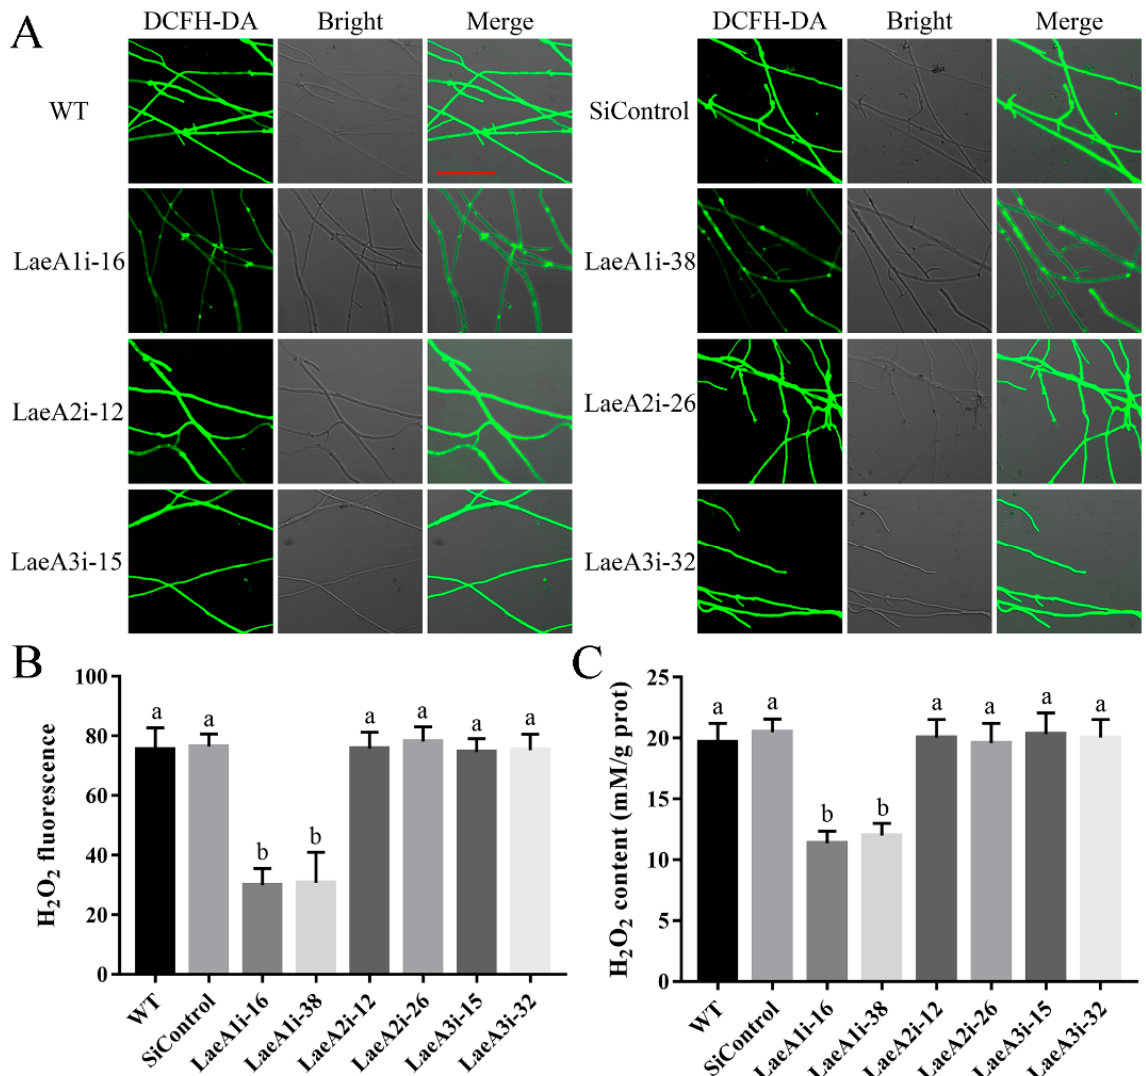
Figure 4. Silencing PoLaeA1 decreased the intracellular ROS levels. ( A ) DCFH-DA staining (scale bar = 100 μ m). The tested strains cultured on CYM plates were stained with the fluorescent H 2 O 2 probe DCFH-DA. ( B ) The H 2 O 2 fluorescence values. The fluorescence was analyzed with ZEN 3.3 (blue edition). ( C ) Intracellular H 2 O 2 levels. The tested strains were cultured in liquid CYM at 28 °C for 5 days. The grounded mycelia were used to determine the intracellular H 2 O 2 levels with a com- mercial hydrogen peroxide assay kit (Nanjing Jiancheng Bioengineering Institute, Nanjing, China). The values are the mean ± SD ( n = 3). Different lowercase letters indicate significant differences between the strains ( p < 0.05, according to Dunnett’s multiple comparisons test).